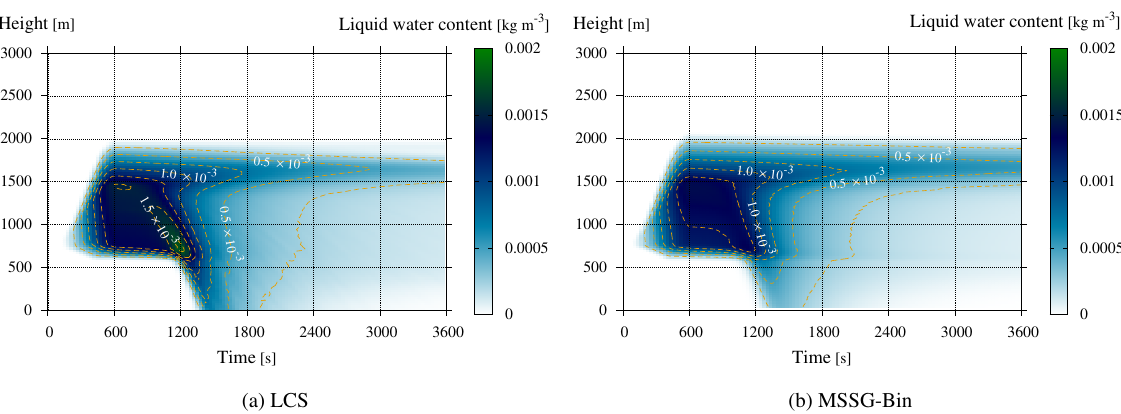
Figure 3. Temporal evolution of the vertical profile of liquid water content for (a) LCS and (b) MSSG-Bin. The yellow dashed lines are isolines at every 2 . 5 × 10 − 4 kgm − 3 . Table 3. Comparison of bulk statistical values between NORM and LARGE runs. The values show (mean) ± (standard deviations). Total amount of surface Total number of surface